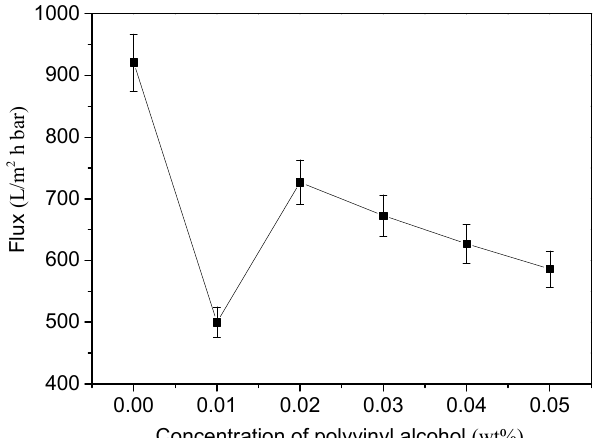
Figure 6. Effect of added PVA contents on pure water flux of MWCNTs/PVDF conductive mem- branes.